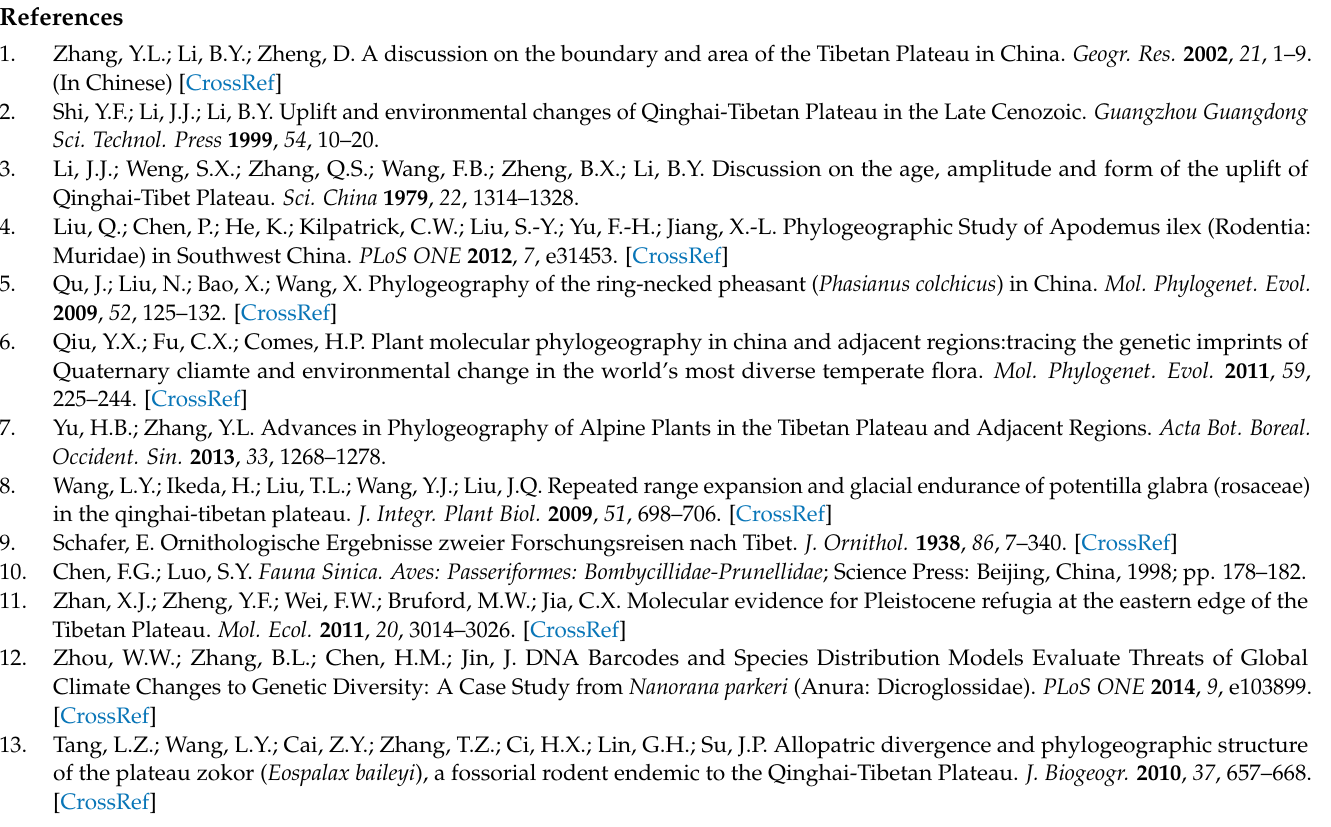
Figure A2. The maximum gene flow ( N m ) results for 42